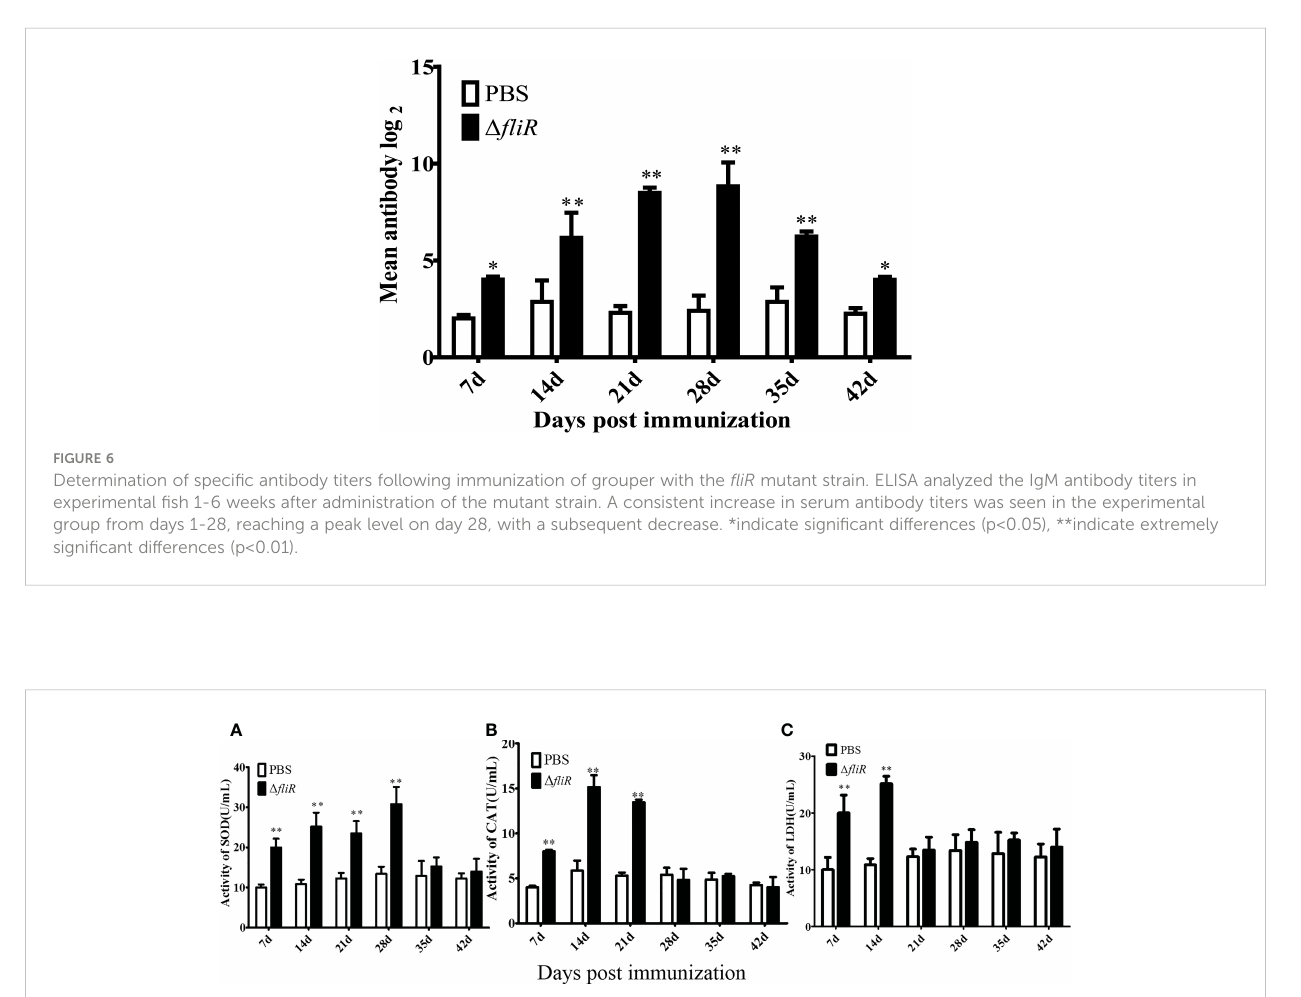
FIGURE 7 Determination of the enzymatic activities of SOD (A) , CAT (B) , and LZM (C) in fi sh serum. SOD activity peaked at week four and returned to normal by week 5. CAT and LDH activity peaked at week two and returned to normal by week 3. *indicate signi fi cant differences (p<0.05), **indicate extremely signi fi cant differences